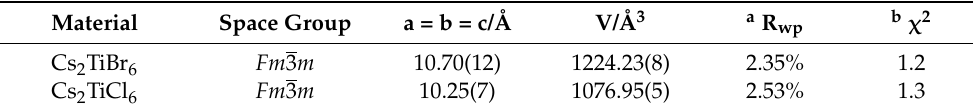
Table 1. Rietveld refinement parameters of Cs 2 TiBr 6 and Cs 2 TiCl 6 NCs obtained from XRD data at room temperature. The numbers in parentheses are the estimated standard deviations of the last significant